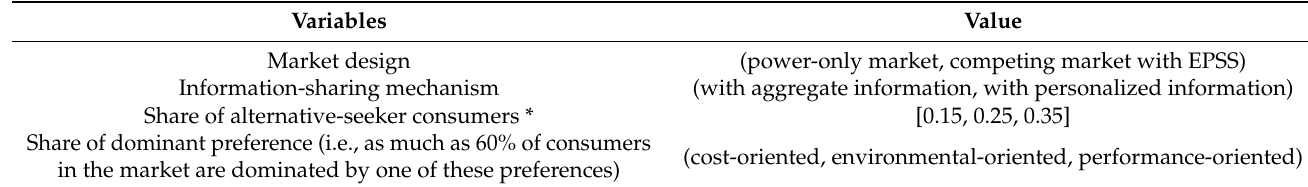
Table 3. Selected variables for scenario design.